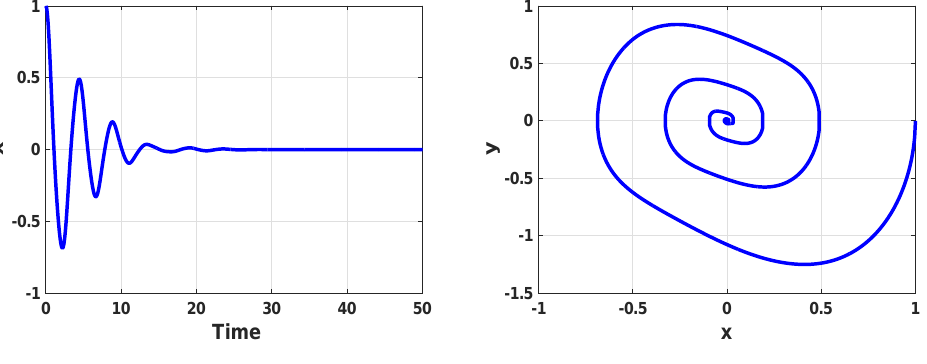
Fig. 3 Solution and phase plane in case of a stable motion at α = 10, β = 1, c = 0 . 5, e = 0 . 2, Γ = 1 and ω =